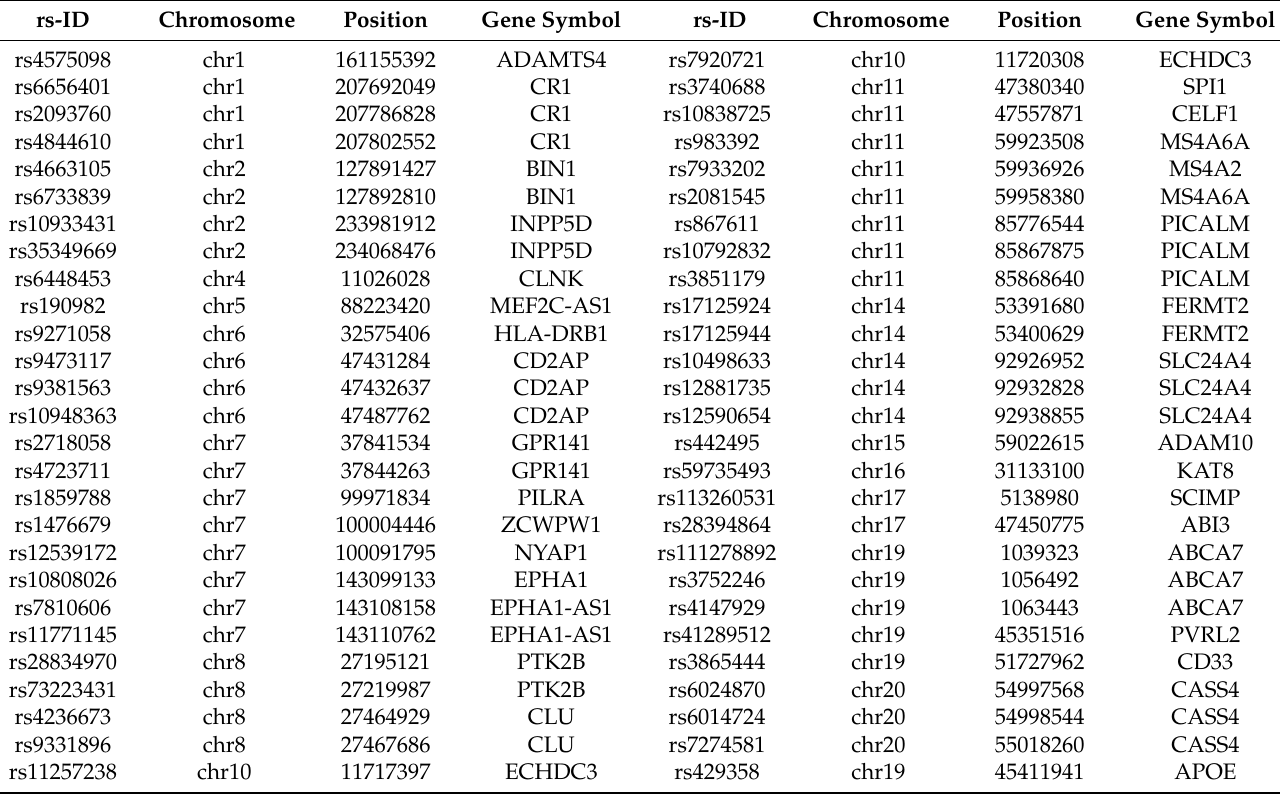
Table A2. Selected AD-related